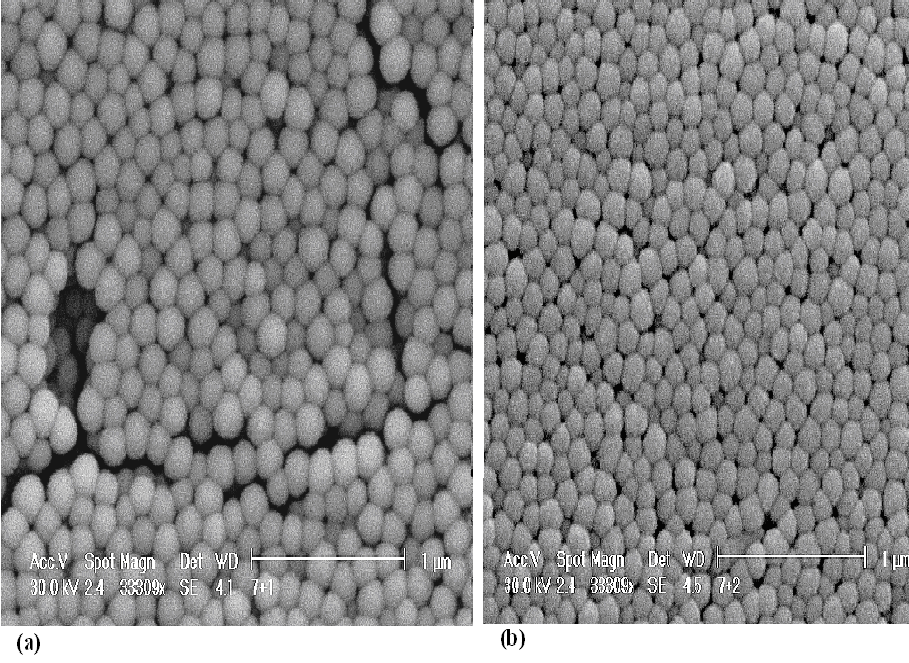
Figure 3. SEM images of SiO